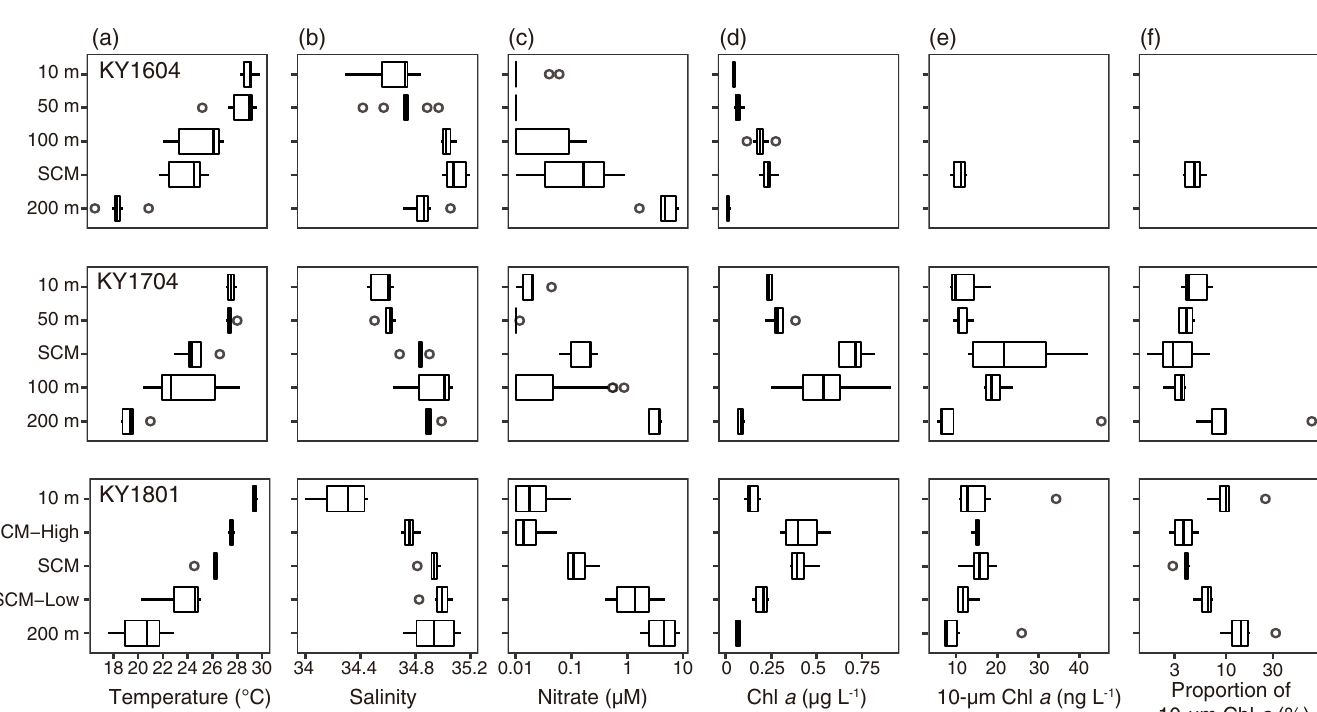
Fig 2. Vertical distribution of (a) temperature, (b) salinity, (c) nitrate concentration, (d) total Chl a concentration, (e) 10 μ m Chl a concentration, and (f) proportion of 10 μ m Chl a concentration to total Chl a concentration for KY1604 (top), KY1704 (middle), and KY1801 (bottom). The thick vertical line in each box represents the median values. Boxes indicate the lower and upper quartiles. Horizontal lines extending from each box represent the minimum and maximum values. The open circles are outliers. On the nitrate concentration and proportion of 10 μ m Chl a concentration, the x-axes are transformed as common logarithms.